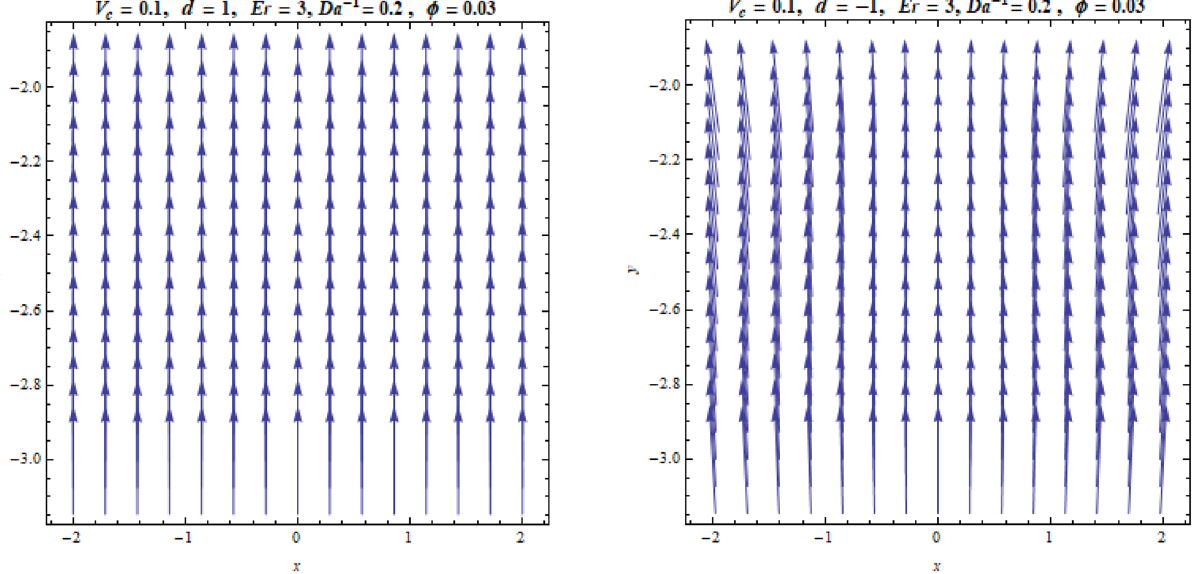
Figure 8. Streamlines representation of the